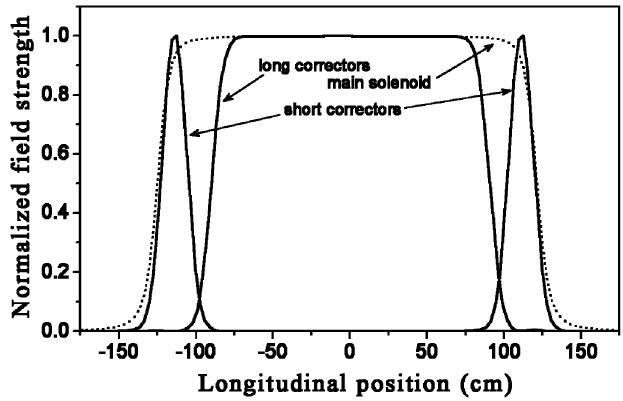
FIG. 5. Normalized strength of the dipole correctors =B ) inside the main solenoid. The solenoid field B ( B x;y max also included (dashed line). The longitudinal position is refer- enced to the geometrical center of the main solenoid. The maximum magnetic field is 8 kG in the short correctors, 2 kG in the long correctors, and 65 kG in the main solenoid.